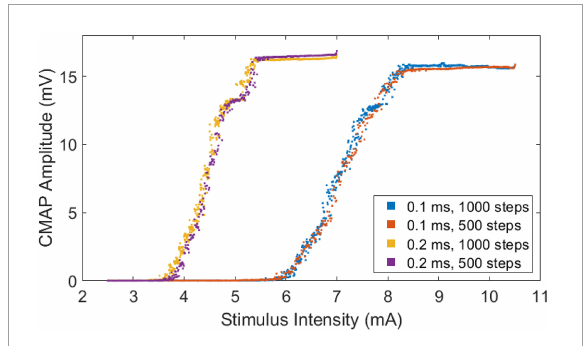
FIGURE2 Stimulus-response curves of a representative subject based at four different CMAP scan